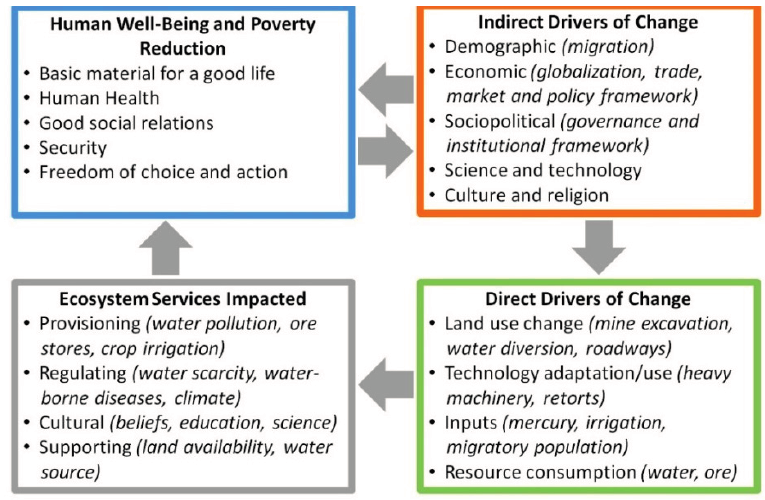
Figure 1. Framework linking key drivers and impacted human/natural systems. Principal domains of inquiry are highlighted. Framework is adapted from the Millennium Ecosystem Assessment